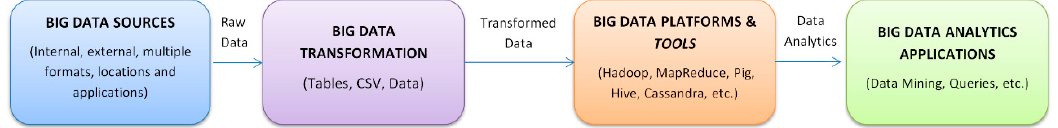
Figure 1. Big Data Workflow.